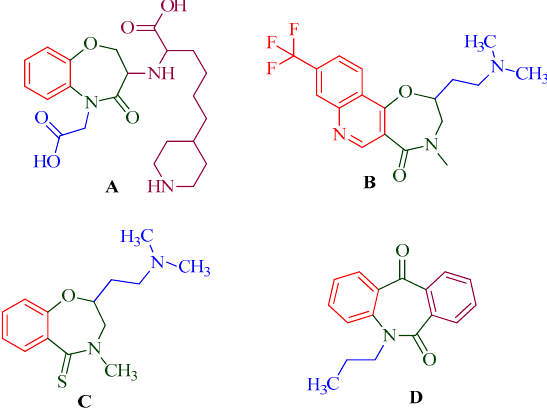
Figure 1. Promising biologically-active oxazepine leads.